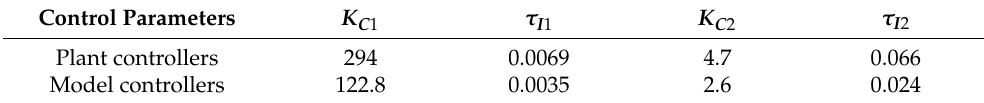
Table 2. Control parameters for the model and